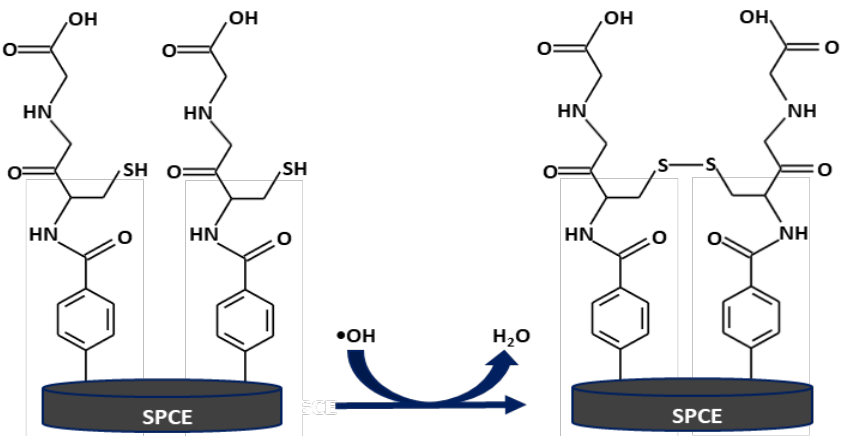
Figure 4. A schematic illustrating the oxidation reaction of the GSH- modified electrode with